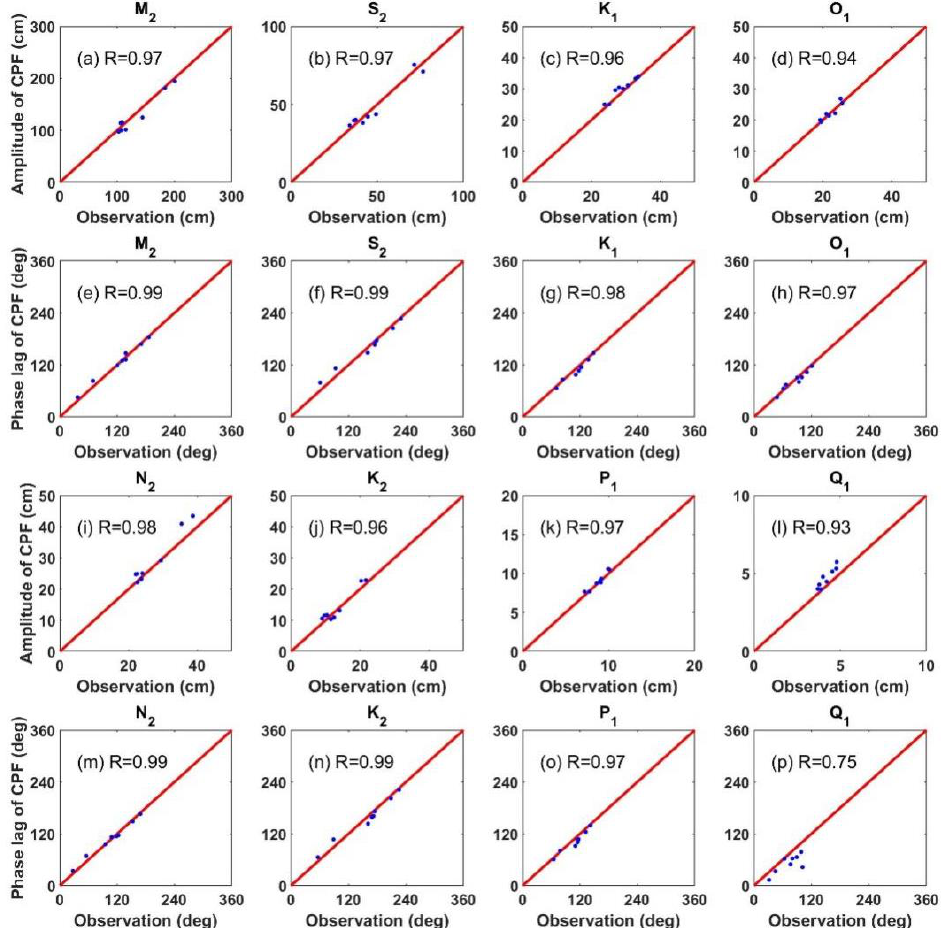
Figure 4. Comparison of the amplitude (unit: cm) and phase lag (unit: deg) from the CPF method and observation at the tidal gauges for the M 2 ( a , e ), S 2 ( b , f ), K 1 ( c , g ), O 1 ( d , h ), N 2 ( i , m ), K 2 ( j , n ), P 1 ( k , o ) and Q 1 ( l , p ) constituents. The red line in each subfigure is shown for comparison. The blue dots in each subfigure represent the amplitude or phase lag of the constituent in each tidal station. The latitude and longitude of the eight gauges are identical with Figure 1.